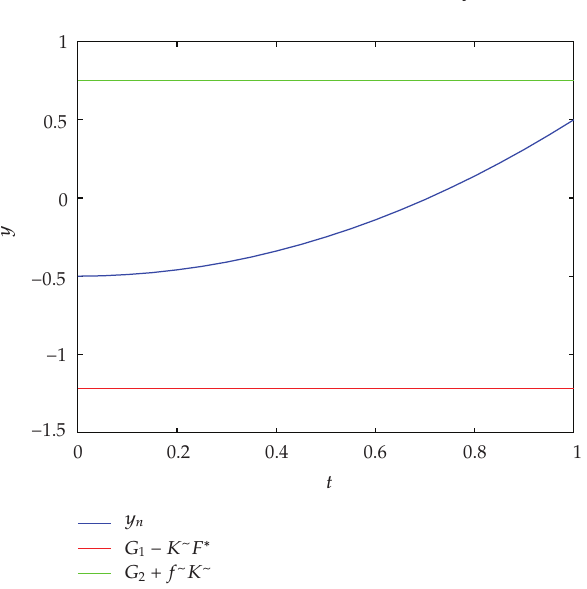
Figure 2: Numerical solution for the problem (cid:2) 1.1 (cid:3) described in Example